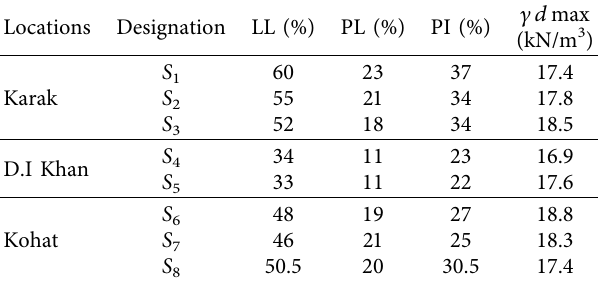
Figure 2: The installation process of G-block and moisture sensors [28]. Table 1: Initial geotechnical and compaction properties of the investigated